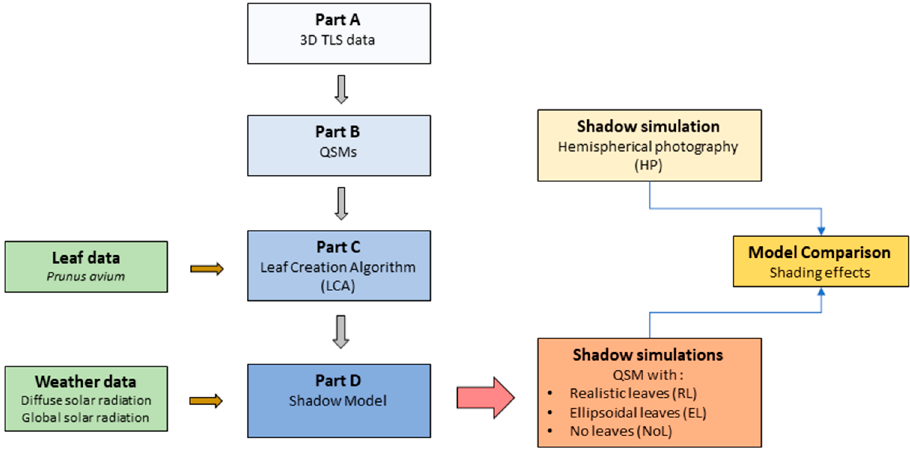
Figure 1. Data sources and development steps of the shadow model aiming for comparisons.